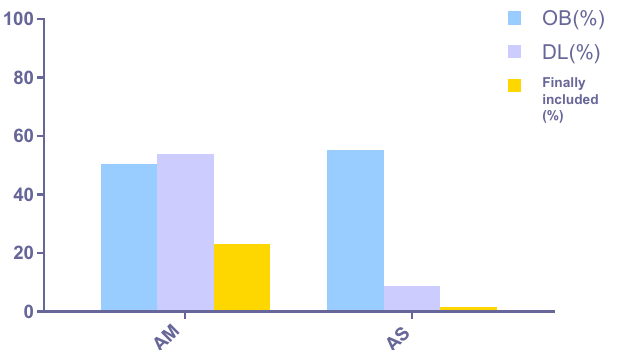
Figure 2. Proportion of active components included. Among the components of AM, 50.57% meet OB ≥ 30%, 54.02% meet DL ≥ 0.18, and the final inclusion ratio is 22.99%. Among the components of AS, 22.99% meet OB ≥ 30%, 8.80% meet DL ≥ 0.18, and the final inclusion ratio is 1.60%.